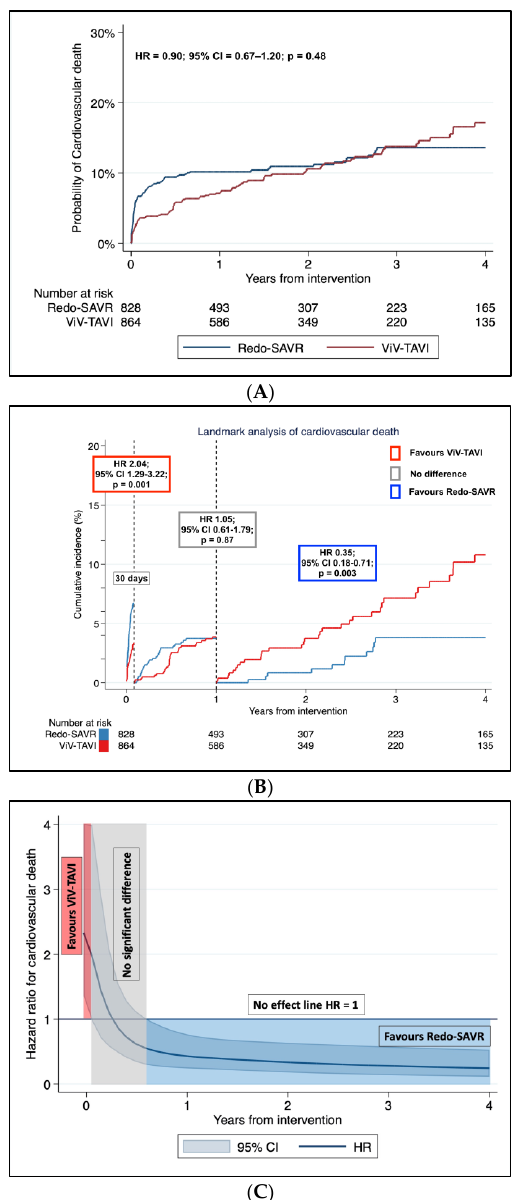
Figure 4. ( A ): Pooled Kaplan–Meier incidence of cardiovascular death in Redo aortic valve re- placement (Redo-SAVR) and valve-in-valve transcatheter aortic valve implantation (ViV-TAVI). ( B ): Landmark analysis of cardiovascular death in Redo-SAVR and ViV-TAVI. Within 30 days from intervention, ViV-TAVI shows a better outcome compared to Redo-SAVR; no difference between